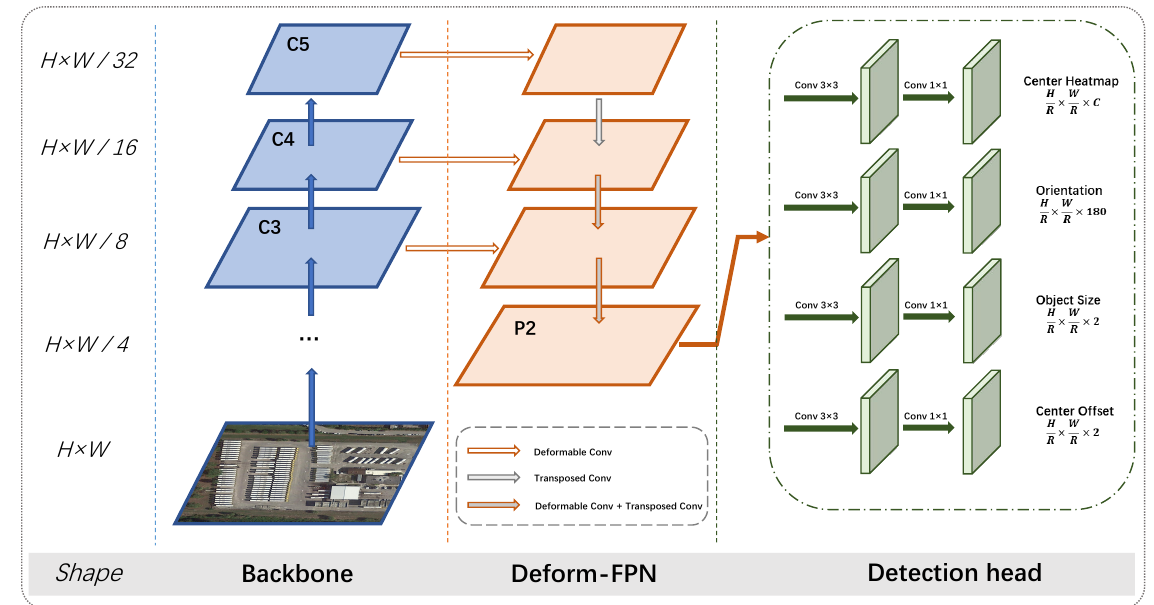
Figure 2. Overall architecture of our proposed center-point based arbitrary-oriented object